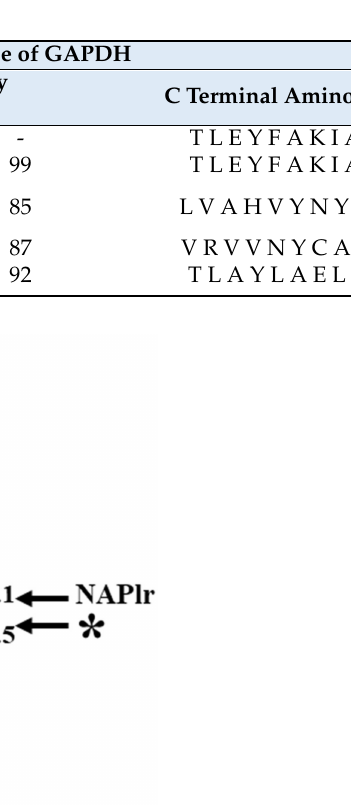
Table 7. Identity, similarity, and C-terminal amino acid sequences of bacterial GAPDH in NAPlr- positive patients with non-streptococcal IRGN.